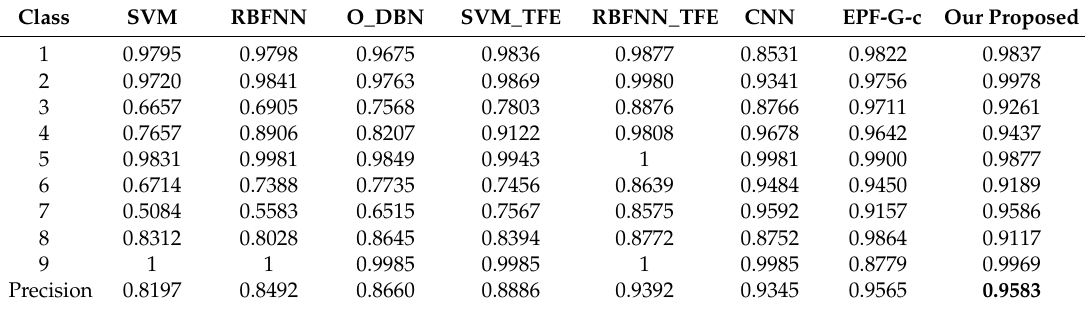
Table 9. Classification precision of different algorithms on University of